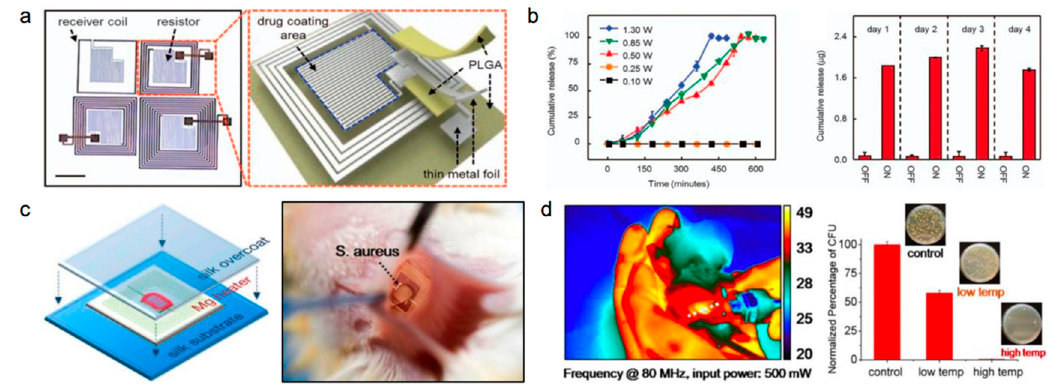
Figure 6. A thermally triggered drug delivery transient device and a radio frequency-controlled thermal therapy platform. ( a ) Images of the device structure. ( b ) Left: Cumulative release of doxorubicin from the device, operated with wireless power. Right: Controllable doxorubicin release from the device over 1 day on/off cycles. ( c ) Left: The schematic illustration of the radio frequency thermal therapy platform. Right: Photo of a device implanted in BALB/c mice. ( d ) Left: The thermal image of the device position while wirelessly powering the device. Right: The normalized number of colony-forming units after 24 h with different levels of input power. Reproduced with permission from [93,97].